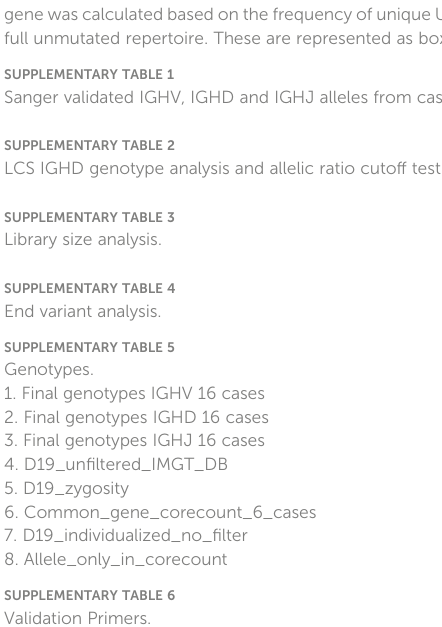
SUPPLEMENTARY TABLE 2 LCS IGHD genotype analysis and allelic ratio cutoff test. SUPPLEMENTARY TABLE 3 Library size